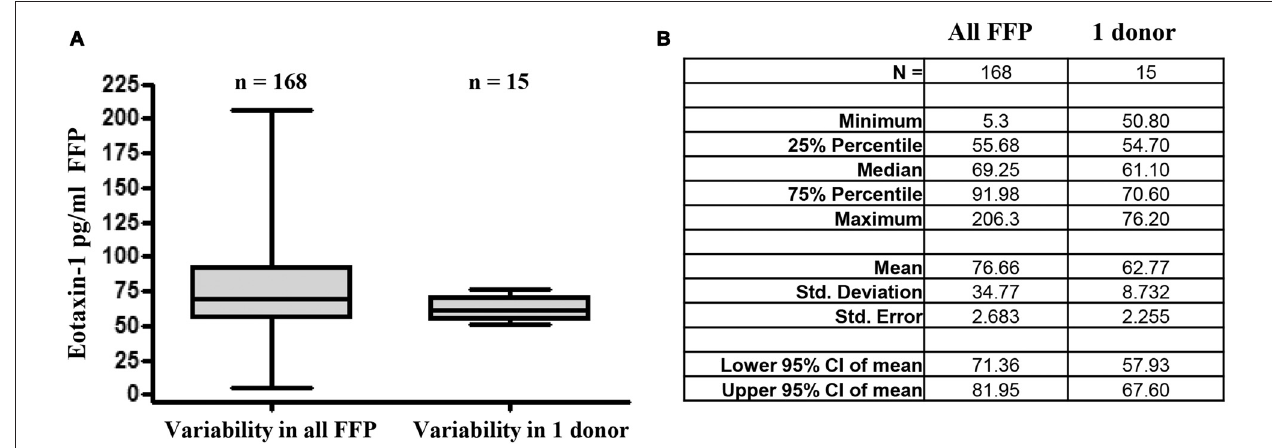
FIGURE 4 | Eotaxin-1 is subject to minor fluctuations within one donor. (A) Eotaxin-1 was measured in FFP of 160 donors, or 15 plasma samples from one volunteer drawn at different time points within a period of 30 days. Plasma has been processed using the same protocol as for FFP. Data are presented as Box-Whiskers Plot showing median, minimum and maximum. (B) Tabular summary and column statistics of samples analyzed in (A)